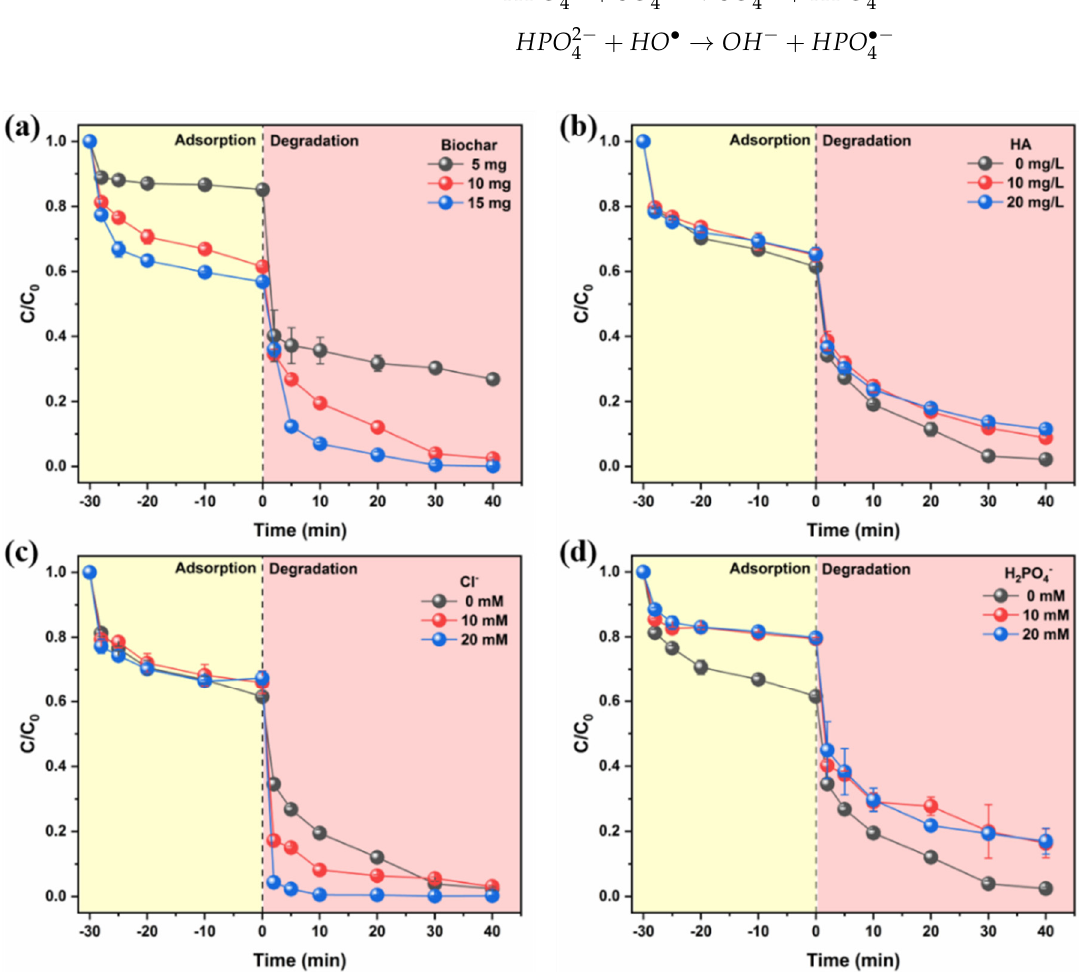
Figure 7. Effects of ASBC800 dosage ( a ), HA ( b ), Cl − ( c ), H 2 PO 4 − ( d ) on SDZ removal.